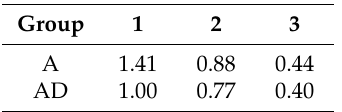
Table 7. Poisson’s ratio of